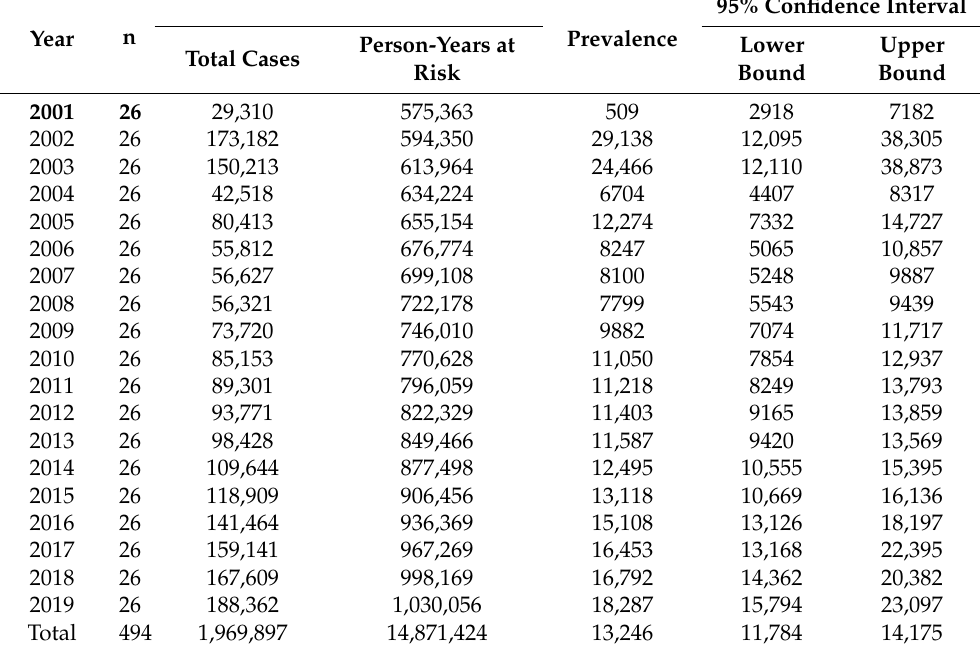
Table 1. Malaria prevalence rate (per 100.000 persons at risk) in DRC, 2001–2019.